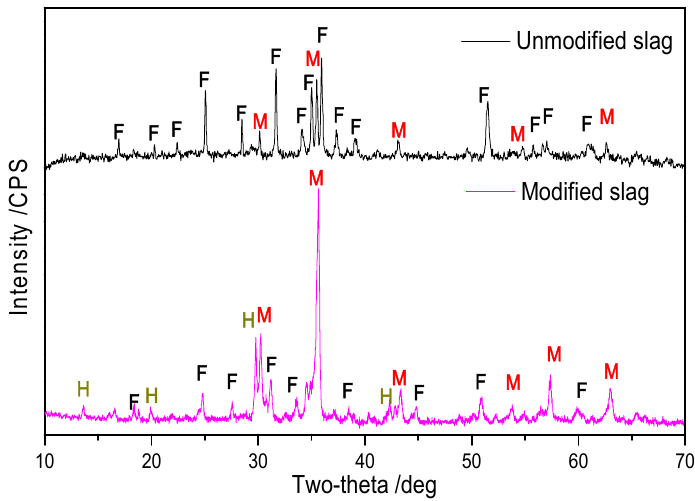
Table 7. Chemical compositions of iron concentrate (mass fraction, %).